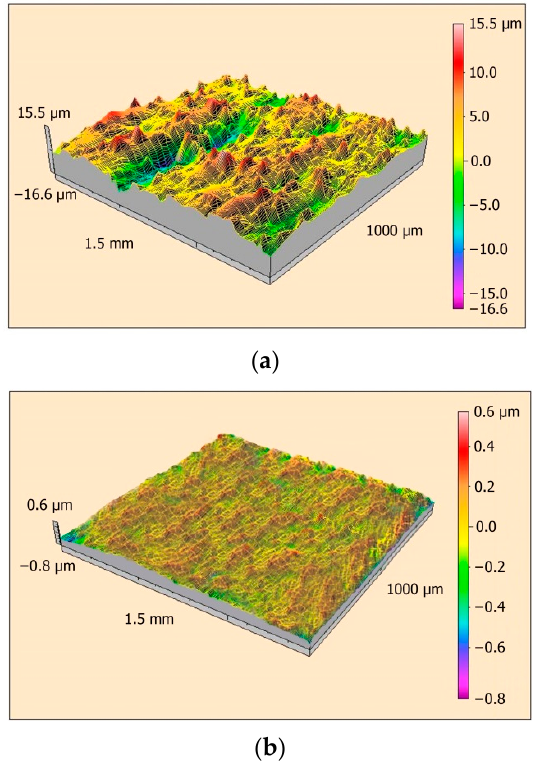
Figure 4. 3D profilograms of the outer surface sample before processing Ra = 5 µm ( a ) and after explosive ablation and polishing with a beam of fast atoms Ra = 0.06 µm ( b ).